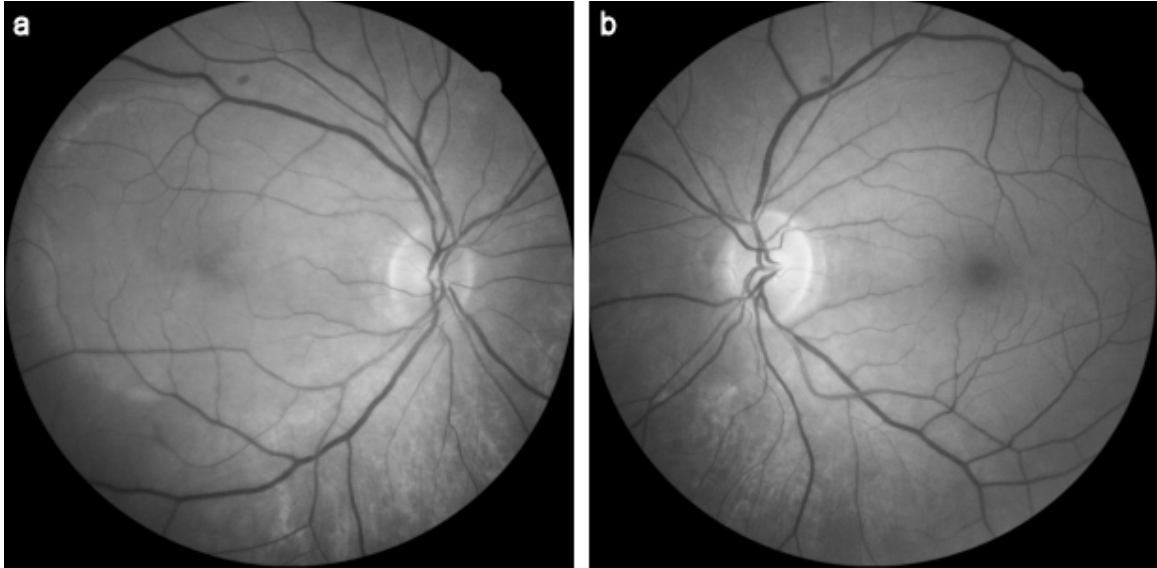
Figure 3: Infrared (IR) images at the time of diagnosis